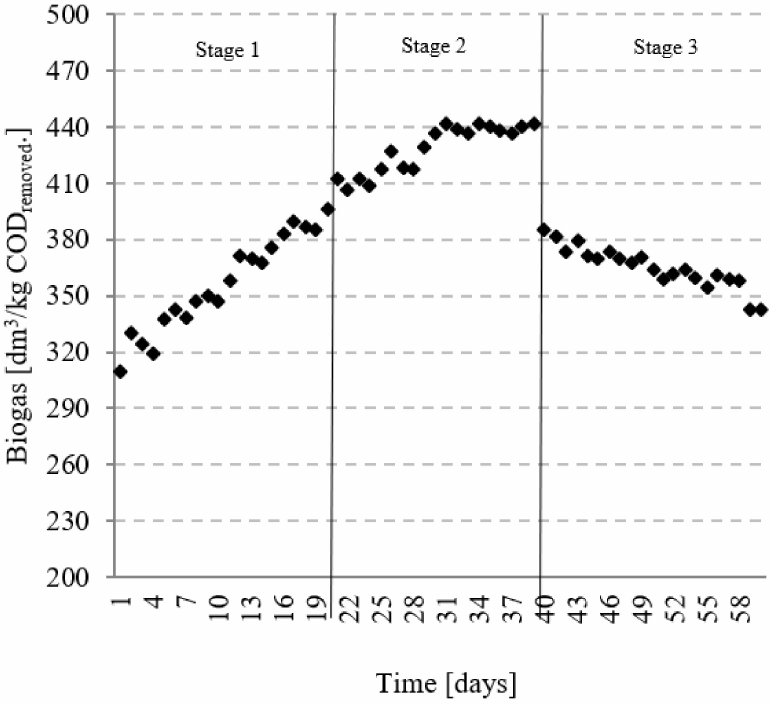
Figure 5. One-time yields of biogas per removed COD load.